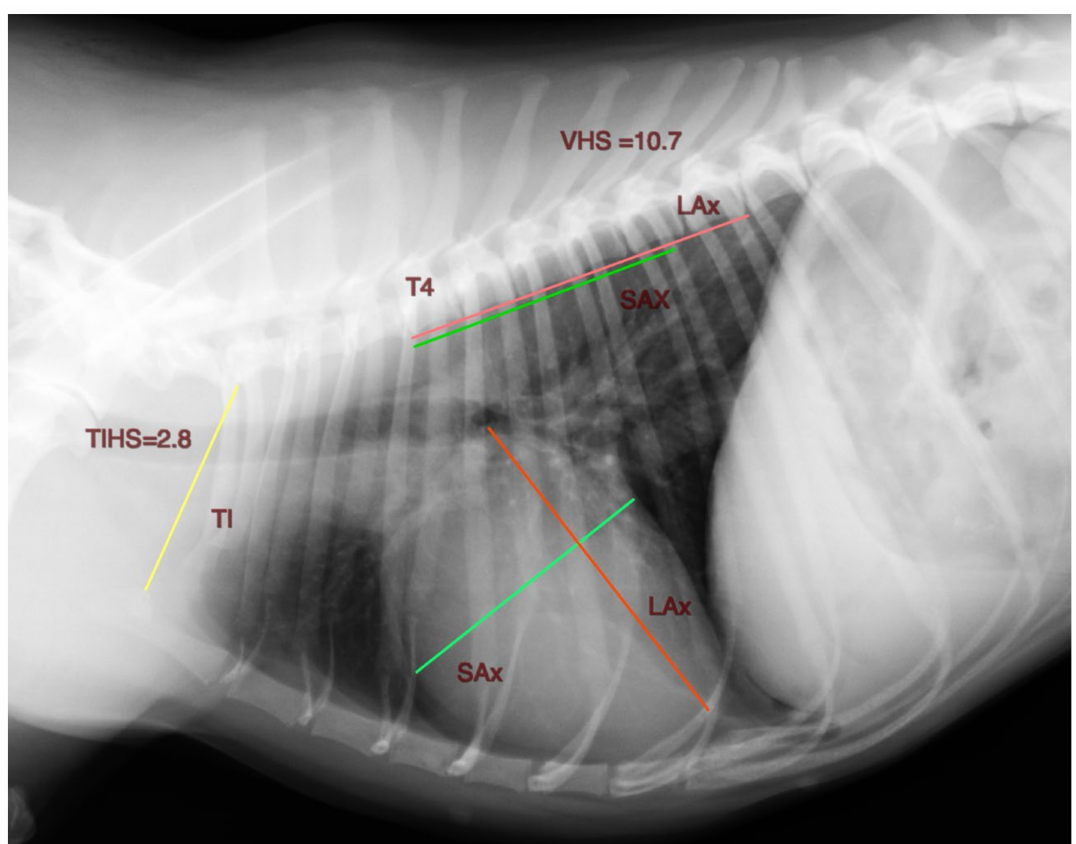
Figure 1. Right lateral thoracic radiographic projection of a clinically normal 9 years old chihuahua illustrating the thoracic inlet heart size measurement method (THIS). The long axis (LAx) and short axis (SAx) of the heart and the thoracic inlet (TI) are measured. The sum of the LAx and SAX is divided by the TI to obtain the thoracic inlet heart size. VHS Vertebral Heart